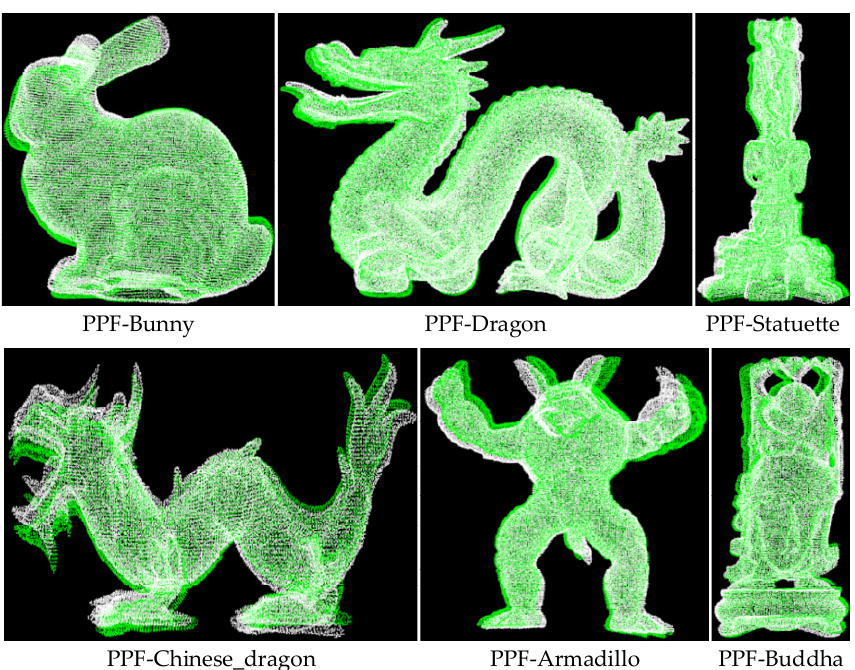
Figure 10. The PPF algorithm is used to register the six kinds of point cloud models of the data set. The pose results are used to convert the point cloud of the models into scene space, and the color is used for rendering, where white represents the point cloud of the scene, and green represents the converted model point cloud.